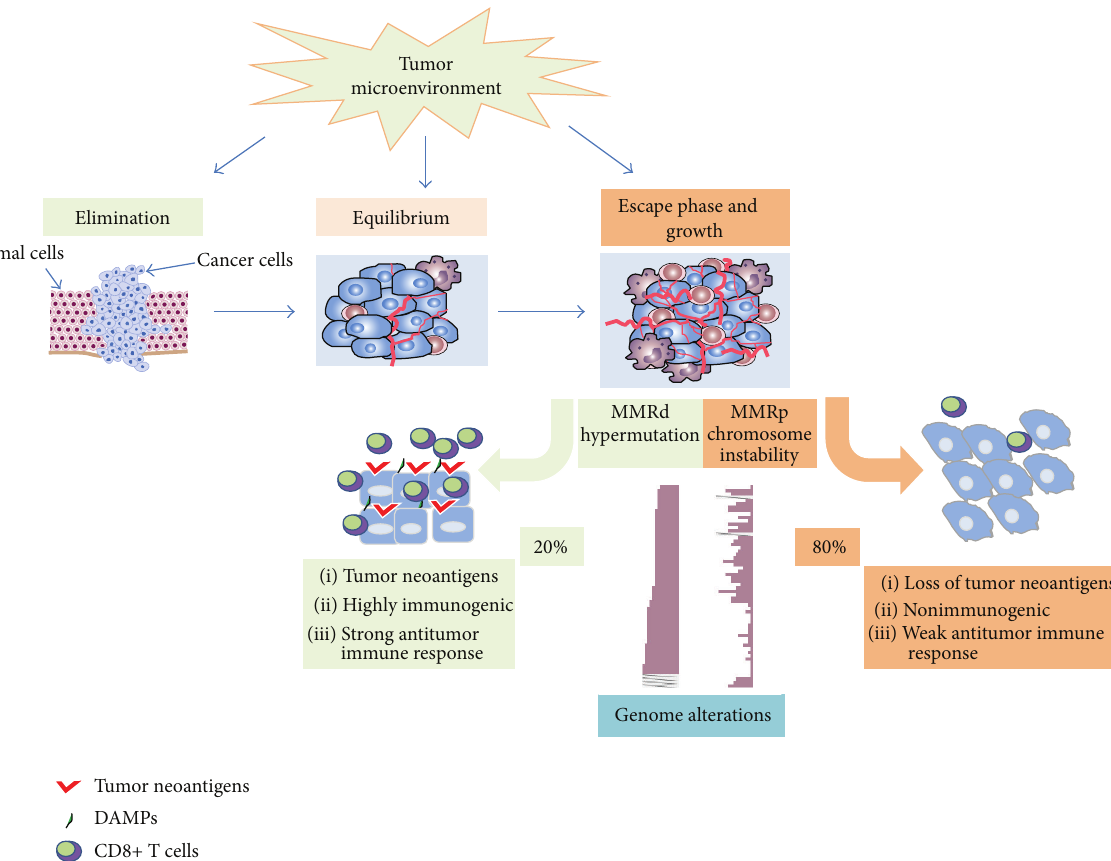
Figure 1: Tumor microenvironment and subversion of immunosurveillance during carcinogenesis. At early stage of primary tumor expansion, the immune system can specifically identify and eliminate tumor cells on the basis of their expression of specific antigens “highly immunogenic tumor.” However, there might not be a complete elimination leading to the survival of some cancer cells that nevertheless remain under immunosurveillance “state of equilibrium.” If the immune response fails to completely eliminate the tumor, cancer cells can avoid or suppress the antitumor immune response leading to a progressively growing tumor. In the case of colorectal cancer (CRC) subtypes, different combinations of genetic and epigenetic changes lead to well distinct microsatellite stable (MMRp) or unstable or MMRd subtypes with different mutational load. Studies have shown that MMRd CRC have a high number of somatic mutations, “hypermutated tumors,” that can give rise to neoepitopes or damage-associated molecular patterns (DAMPs) and that these may serve as neoantigens for activation of tumor-specific CD8 T cell responses. The large majority of CRC are nonhypermutated cases tending to exhibit chromosomal instability associated with loss of tumor antigens, loss of human leukocyte antigen molecules, loss of sensitivity to complement, or T cell lysis, making them a poor target of an immune